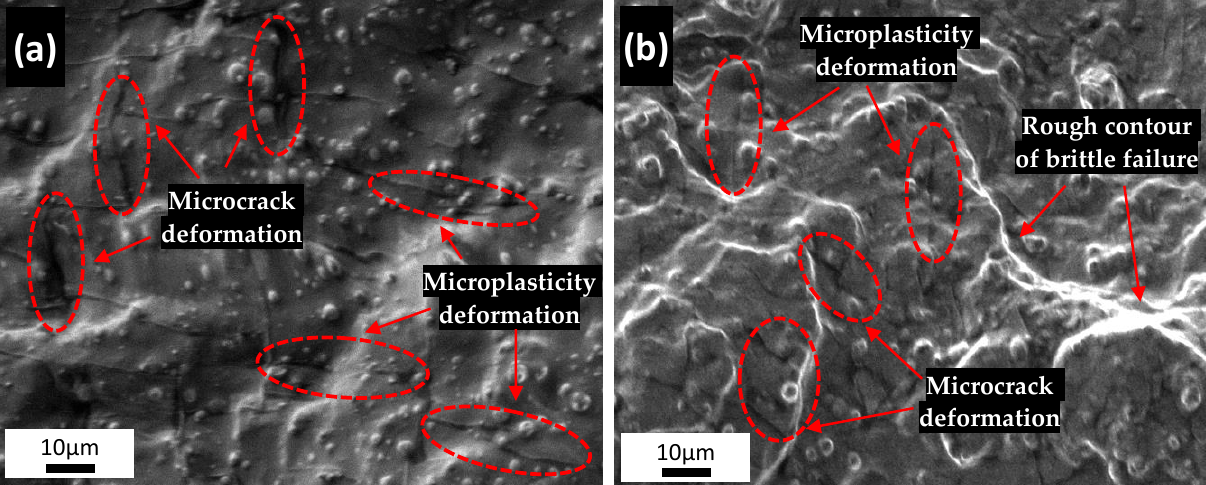
Figure 7. FESEM images of an MRE sample at tension loading under magnetic influenced at CIP concentrations of MREs with ( a ) 10 vol.% and ( b ) 20 vol.%.